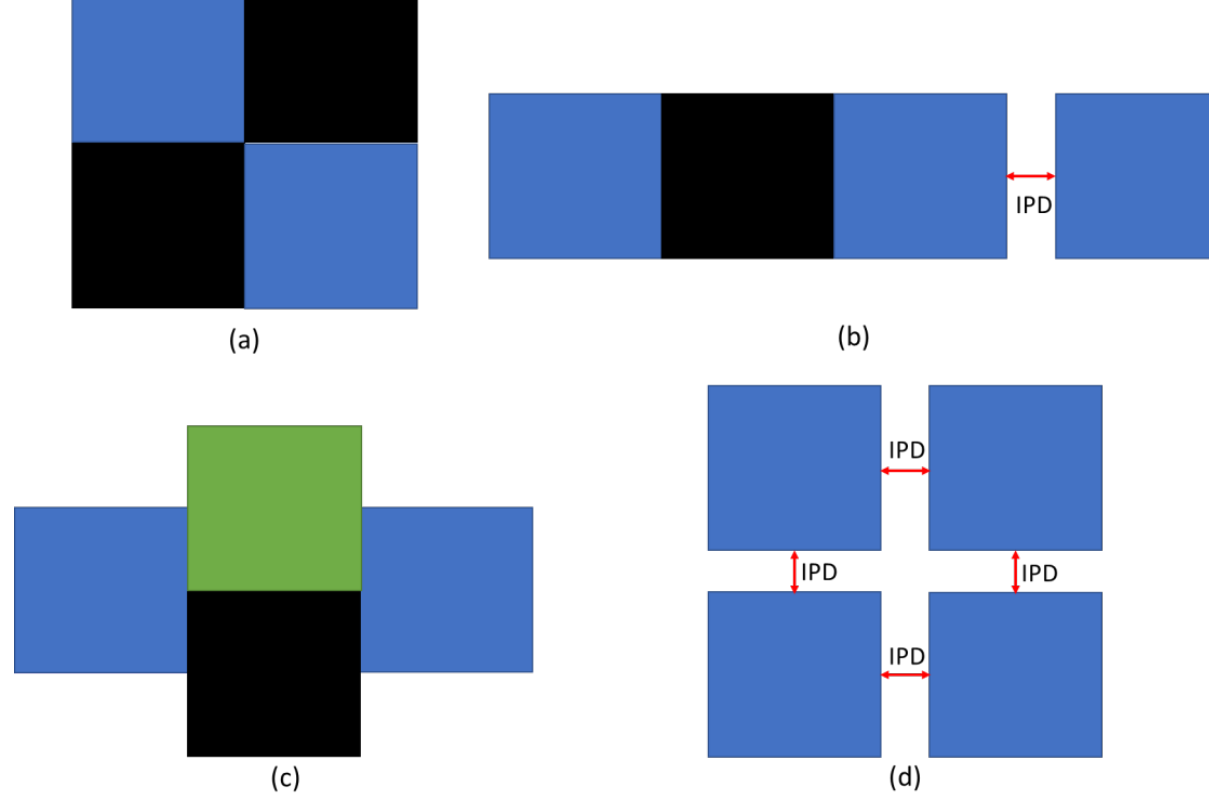
Figure 8. Various farm subdivisions, with no Inter-Plot Distance (IPD) in ( a ) and ( c ), and acceptable Inter-Plot Distance (IPD) in ( b ) and ( d ).